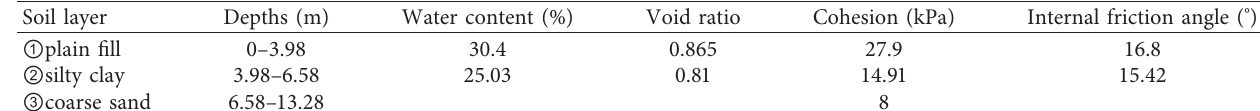
Figure 6: Cross section of pipe jacking group. Table 1: Main geotechnical parameters of soils at the construction